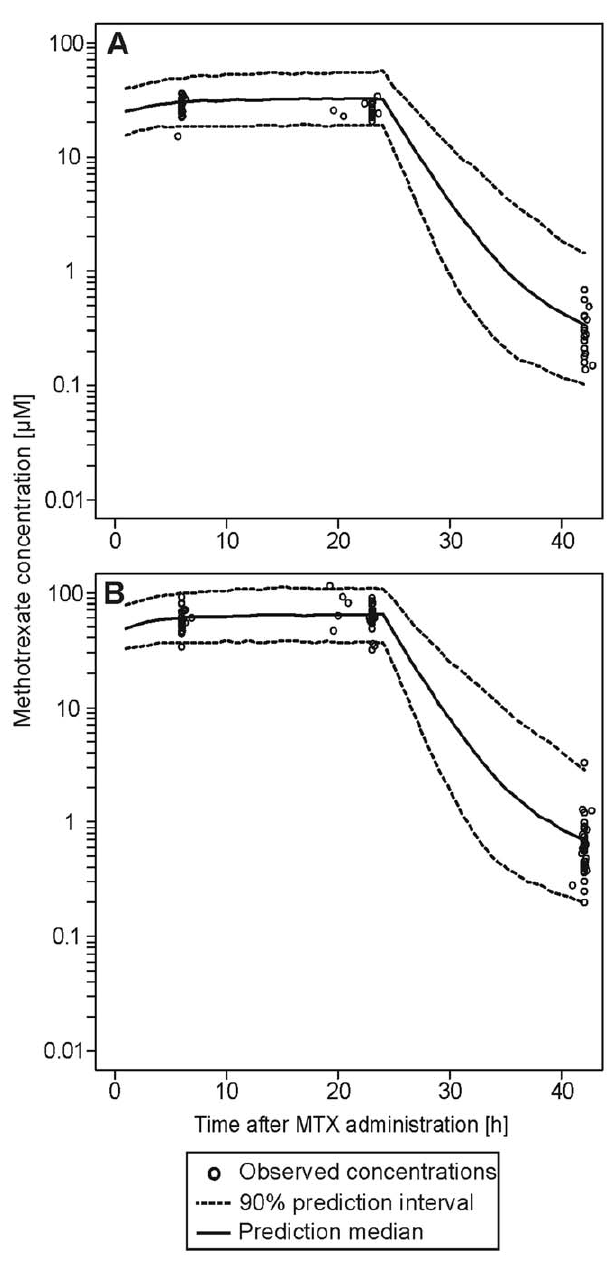
Figure 3. Visual predictive check of the pharmacokinetic model for all patients of the evaluation dataset receiving a 24 h MTX infusion with a dose of 2500 6 20 mg/m 2 (A) and 5000 6 20 mg/ m 2 (B), respectively. The black circles represent the measured methotrexate concentrations. The solid line represents the median predicted concentration, the dashed lines represent the 90% prediction interval of 10000 simulations.